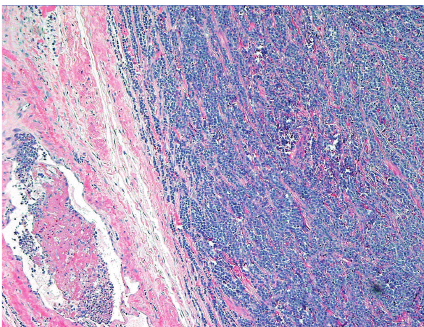
Figure 2: Architectural effacement and replacement of testicle by a diffuse proliferation of immature myeloid cells (H & E stain).